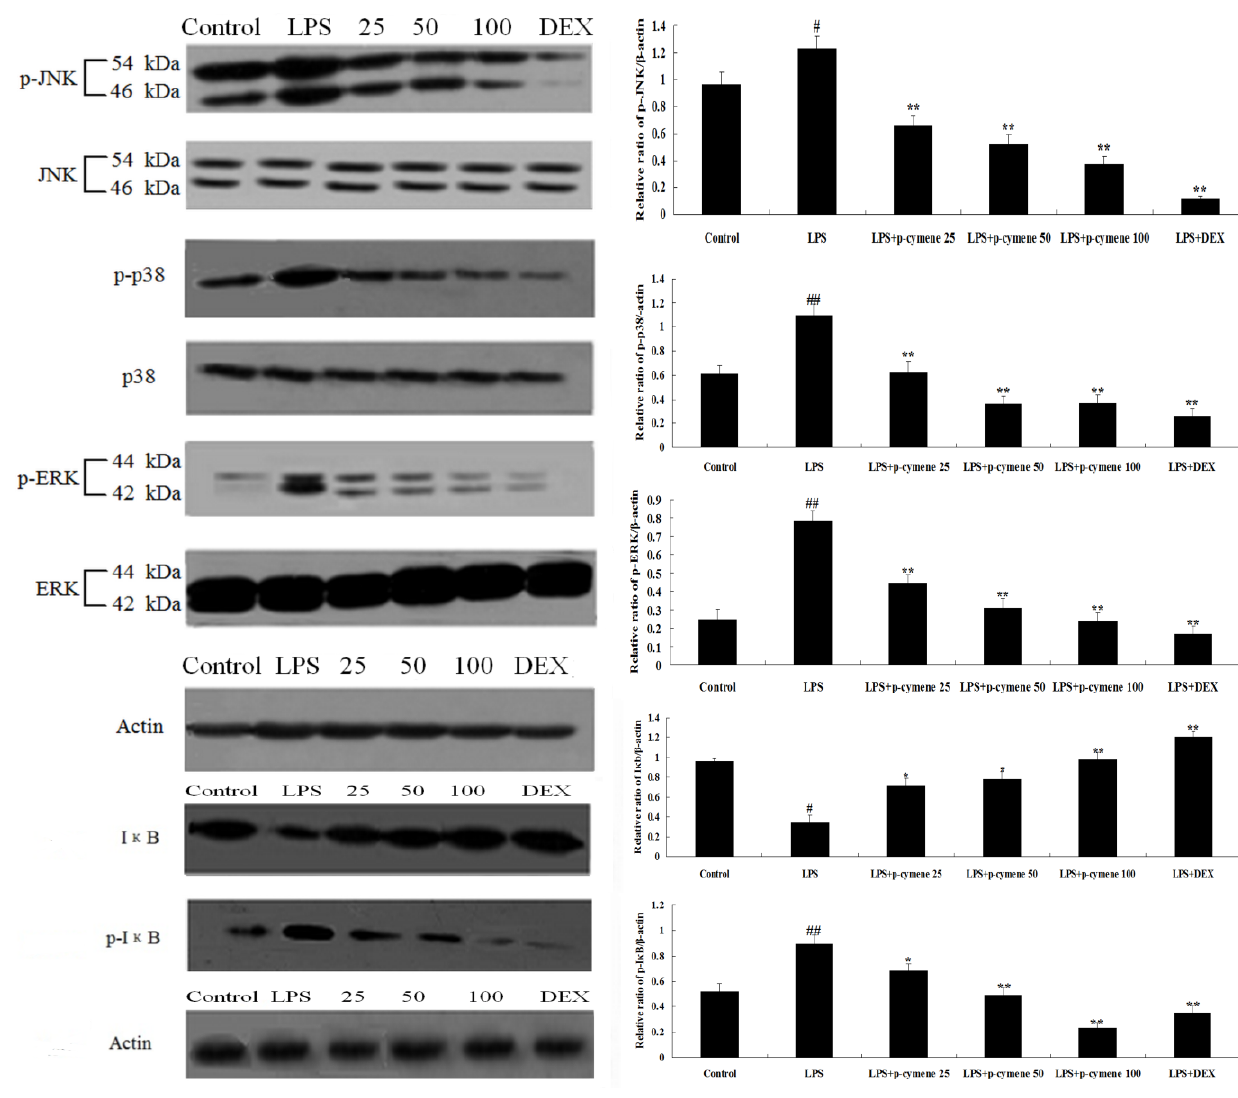
Figure 7. Effect of p -cymene on LPS-induced MAPK and NF- κ B pathways. To induce ALI, LPS was instilled intranasally 1 h after intraperitoneal administration of p -cymene (25, 50 or 100 mg/kg). Quantification of protein expression was normalized to β -actin using a densitometer (Imaging System). The data are representative of three independent experiments and expressed as mean ± SEM. p < 0.01 indicates significant differences from the